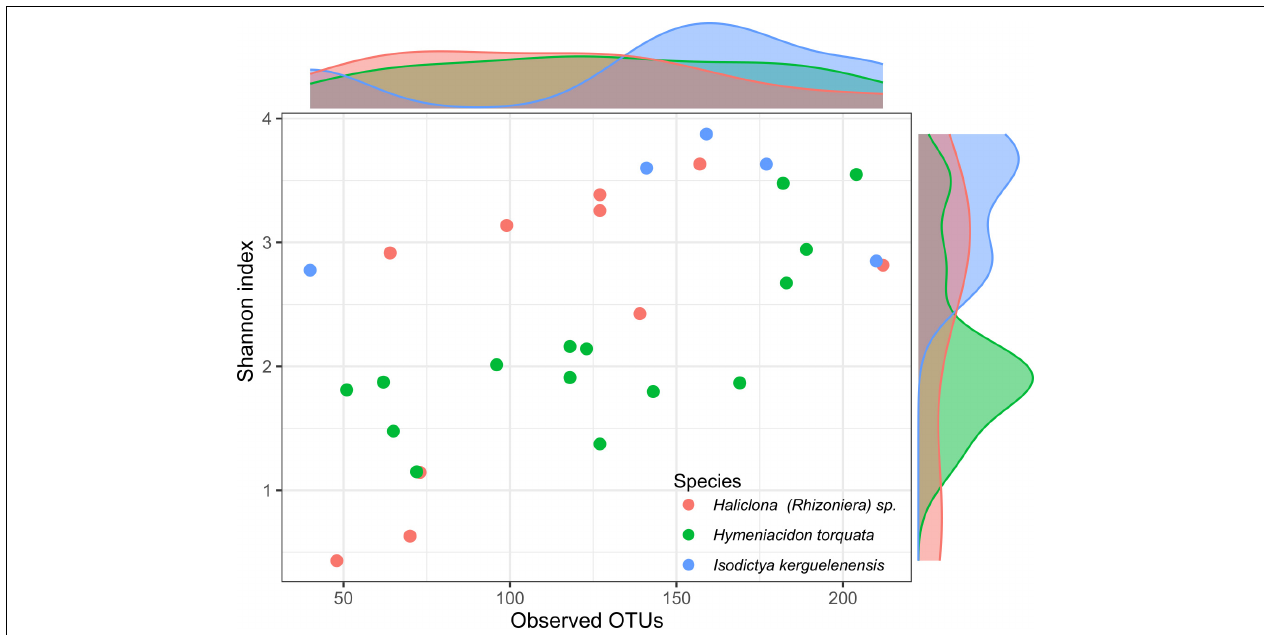
FIGURE 1 | Richness and diversity patterns of Antarctic sponge-associated bacteria. Histograms at the top and right-hand side of the plot show the distribution of observed operational taxonomic units (OTUs) and Shannon index, respectively, for the individuals of the three sponge